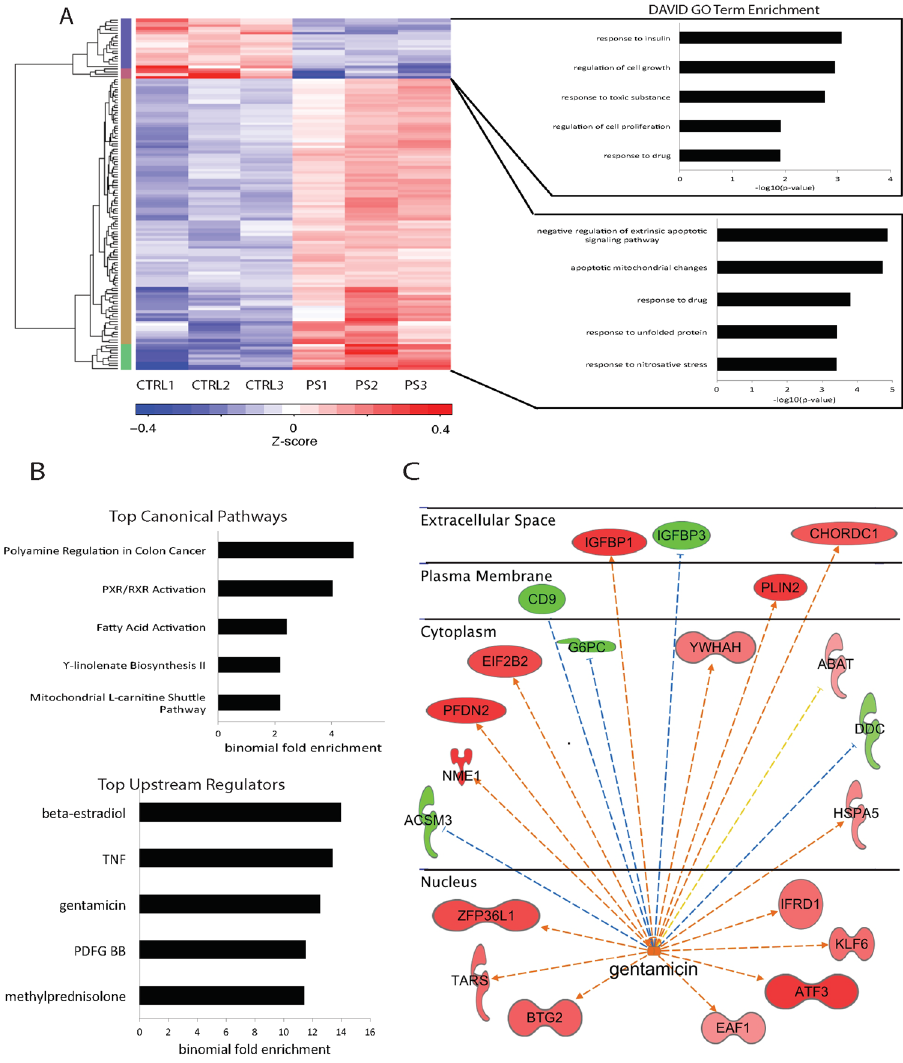
Figure 2. RNA-seq analysis on HepG2 cells cultured with and without PenStrep. ( A ) Shown in the top left is a heatmap depicting relative expression levels for all 209 differentially expressed genes across all three replicates per treatment. To the right of each cluster, the top gene ontology terms as determined by DAVID v6.8 24 are shown. ( B ) PenStrep DE genes canonical pathways and upstream regulators with the top five highest binomial fold enrichment values and most significant p-values as determined by IPA. ( C ) IPA network analysis for gentamicin, one of the top most significant upstream regulators for PenStrep DE genes. This network is drawn based on calculated z-scores for published gene expression patterns under gentamicin as determined by